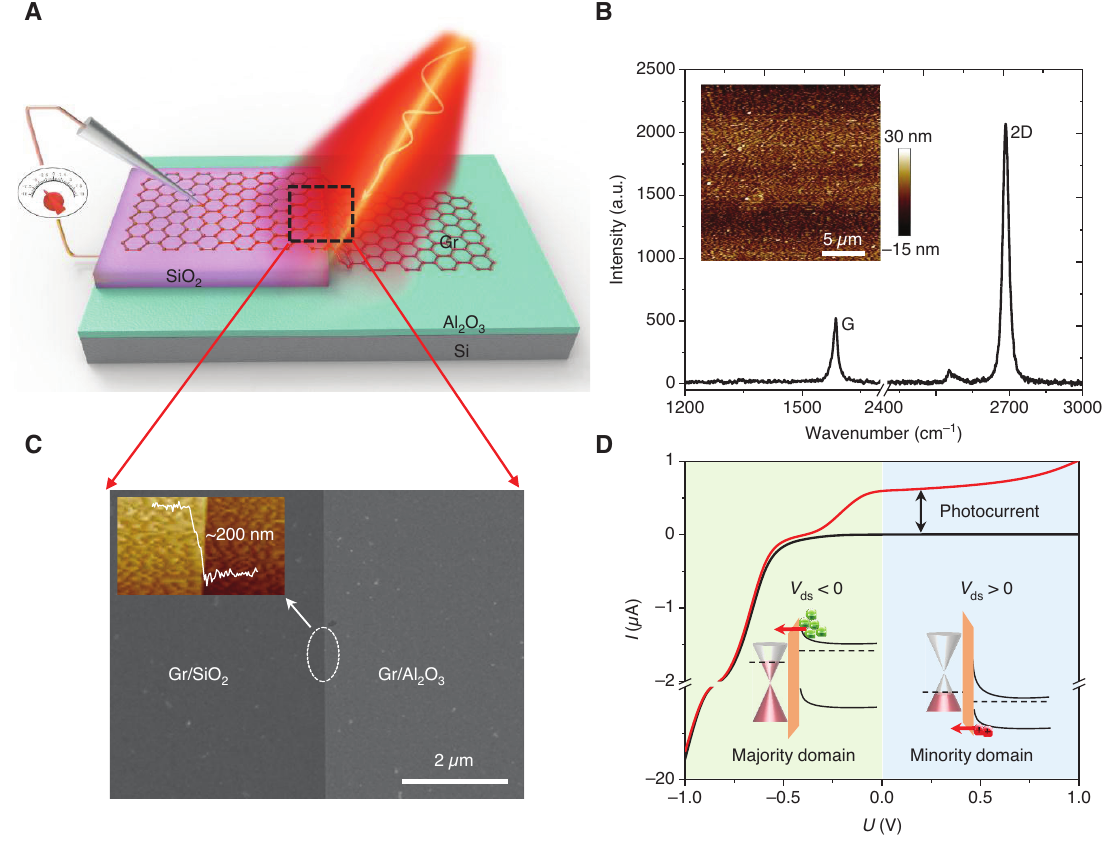
O /Si heterojunction photodetector. 2 3 O tunneling layer. (C) SEM image of the graphene at the interface; inset: AFM 2 3 insulator is ~ 200 nm. (D) I/V curves of the Gr/Al 2